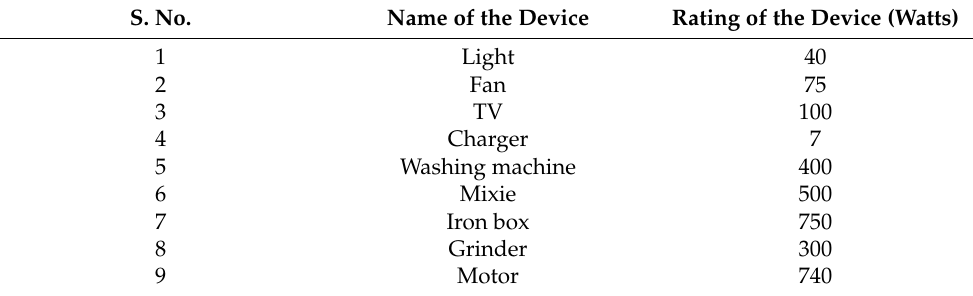
Table 2. Details of the residential load.